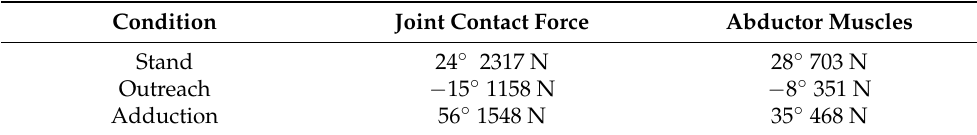
Table 1. Loads on the proximal femur under three operating conditions.